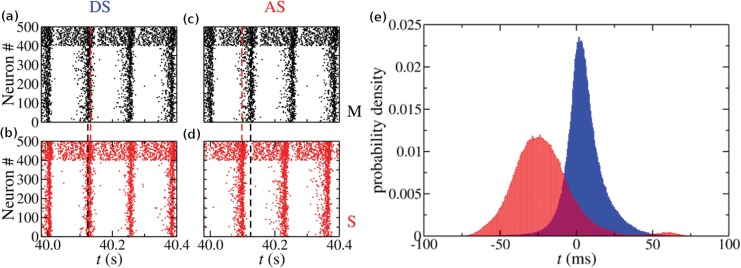
Neuronal firing patterns in the DS and AS regimes due to STDP.(a)-(d) Raster plots of each population in the DS and AS regimes. Black dots are neurons from the Master population. Red dots are neurons from the Slave-Interneuron population. Neurons 0 to 399 are excitatory, whereas neurons 400 to 499 are inhibitory. (e) Histogram of the time delay between the closest spikes in each cycle of all coupled pairs whose pre-synaptic neuron is in the M population and the post-synaptic neuron is in the S population. The blue distribution represents a DS regime and the red distribution represents an AS regime. The inhibitory conductances in the S population is set to g
IS = 16 nS in the DS regime, and g
IS = 4 nS in the AS regime.